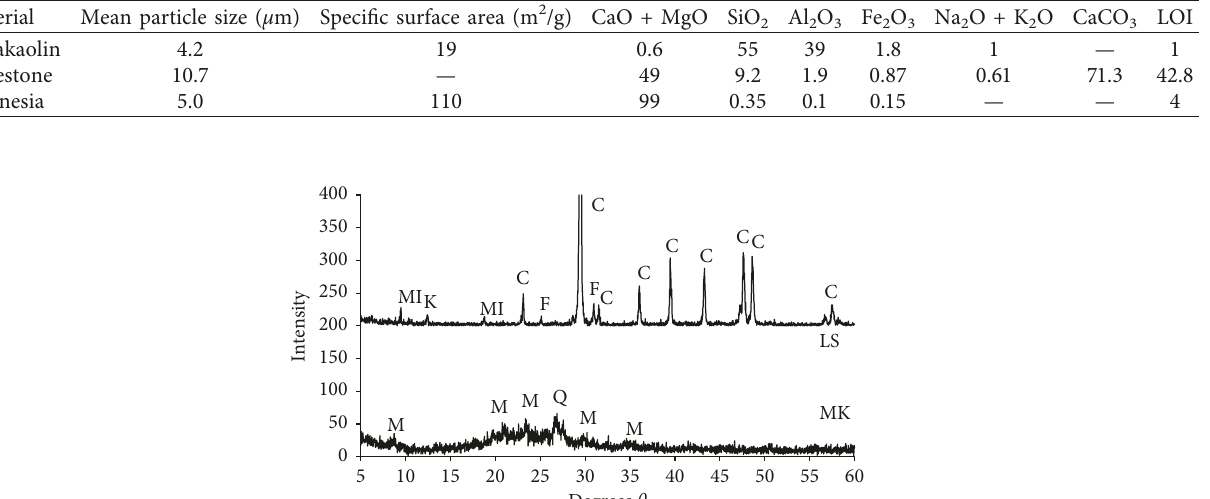
Table 1: Properties of metakaolin, limestone, and magnesia.